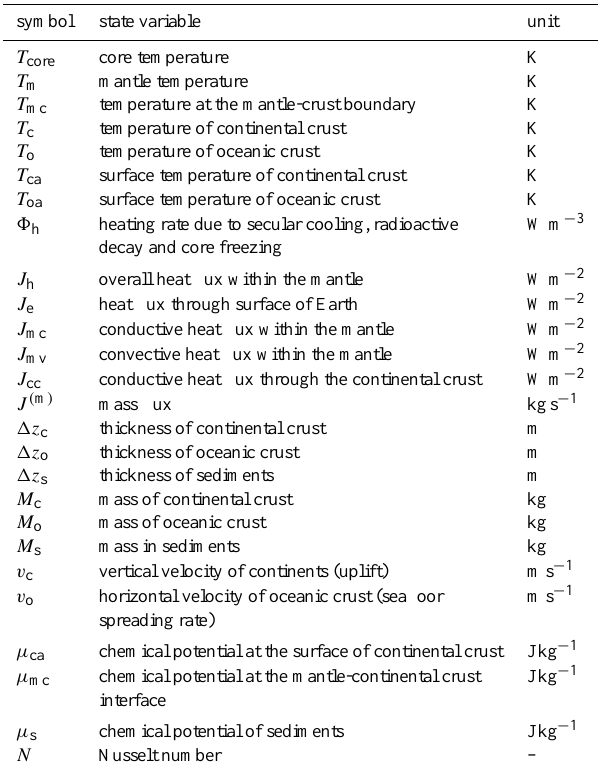
Table 3. Characterization of system states and